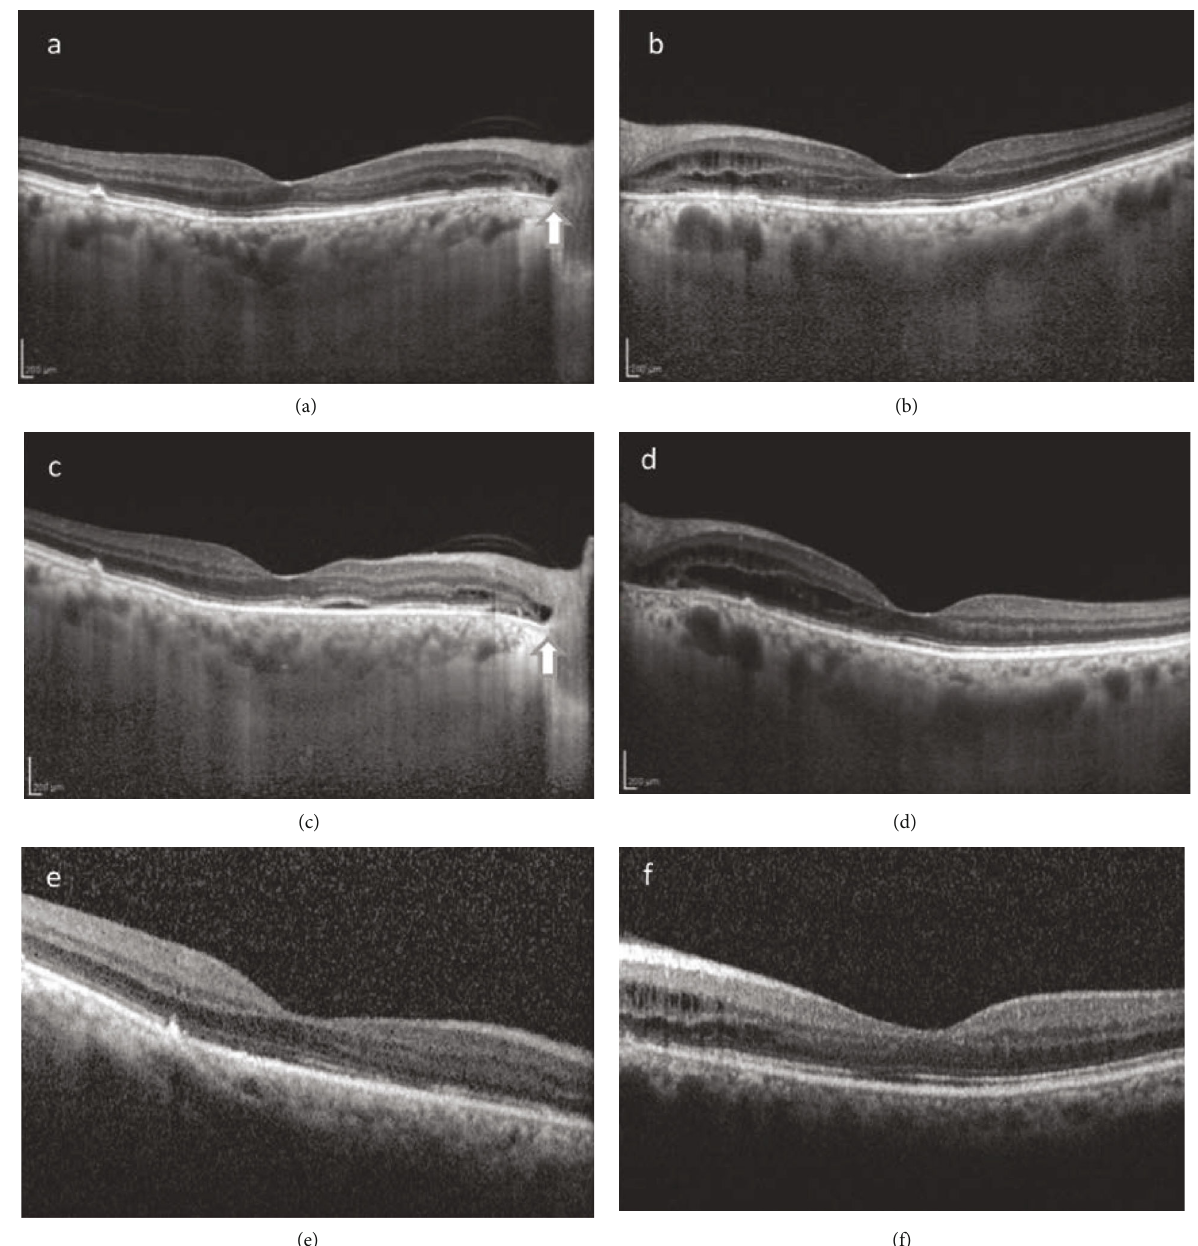
Figure 4: ECI-OCT 3 months after topical and systemic treatment with CAIs and diclofenac drops showed resorption of SRF in both eyes (a and b) with some IRF remaining temporally to the optic disc ( LE > RE ). A relapse was noted one month later: EDI-OCT showed a small amount of SRF in RE (c) and deterioration with the presence of IRF in the LE (d). OCT after treatment with dexamethasone eye drops: the RE is completely dry (e), and a small amount of IRF remains temporally to the ONH in the LE (f). The arrow denotes the PFP persisting in the